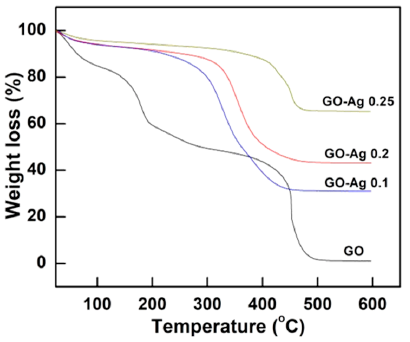
Figure 6. TGA weight loss of GO, GO-Ag 0.1 M, GO-Ag 0.2 M, and GO-Ag 0.25 M composites.